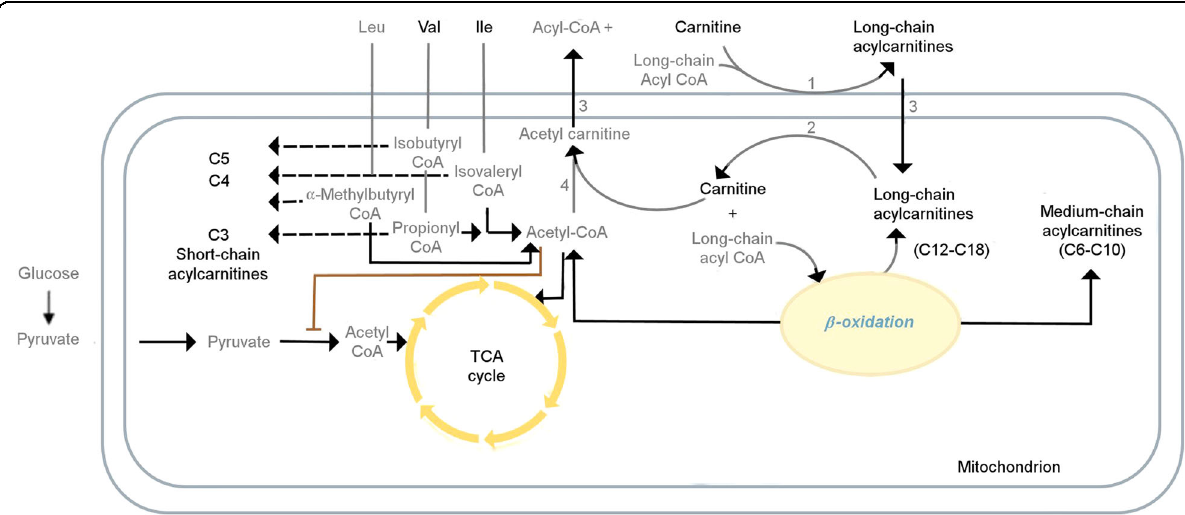
Fig. 1 Role of acylcarnitines in β -oxidation of fatty acids. Mitochondrial energy metabolism pathways involve branched-chain amino acids (BCAAs), acylcarnitines, fatty acid beta-oxidation, and tricarboxylic acid cycle (TCA cycle). A delicate balance between two of the main cellular energy resources, glucose utilization, and fatty acid utilization, is essential to maintain physiological homeostasis, the perturbation of which may lead to pathologic processes. The gray font metabolites have not been measured in p180. Leu leucine, Val valine, Ile isoleucine, CoA coenzyme A, CPT1 carnitine-palmitoyl-transferase 1, CPT2 carnitine-palmitoyl-transferase 2, CACT carnitine-acylcarnitine-translocase, CrAT carnitine O-acetyltransferase. Metabolite abbreviations are spelled out in Supplementary Table